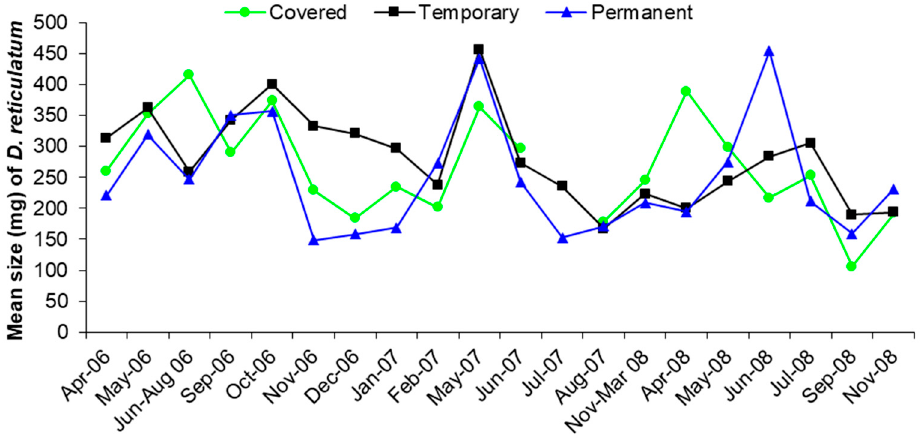
Figure 5. The average size (mg) of Deroceras reticulatum for each sampling period found in each trap type.